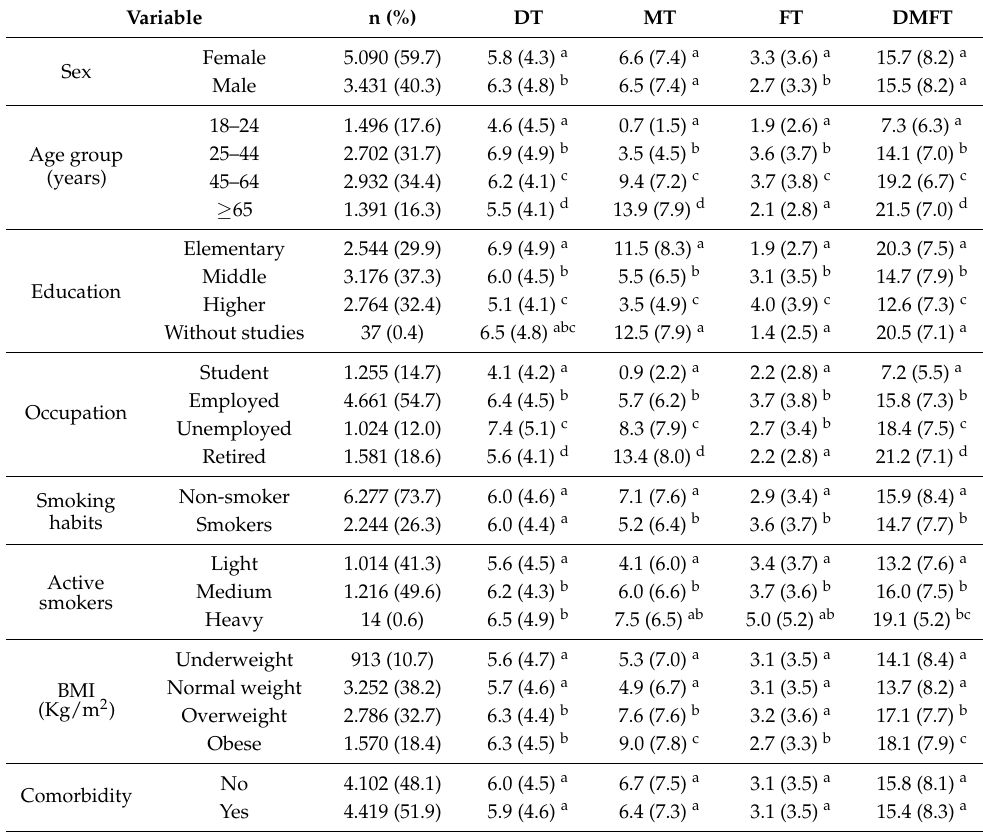
Table 3. Dental caries data (presented as mean and standard deviation) as function of sociodemo- graphic, health, and behavior factors (n =